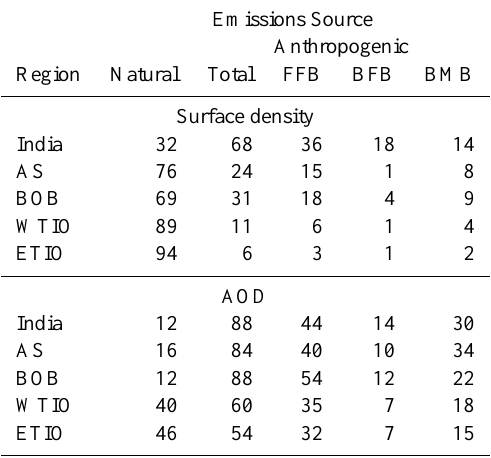
Table 8. Relative contributions of source processes to the surface aerosol density and AOD (in %, all values rounded to the nearest integer) for the five subregions noted in the text: AS=Arabian Sea; BOB=Bay Of Bengal; WTIO=Western Tropical Indian Ocean; ETIO=Eastern Tropical Indian Ocean (based on data in Table 1 of Verma et al., 2008, copyright 2008 by the American Geophysical Union, adopted with